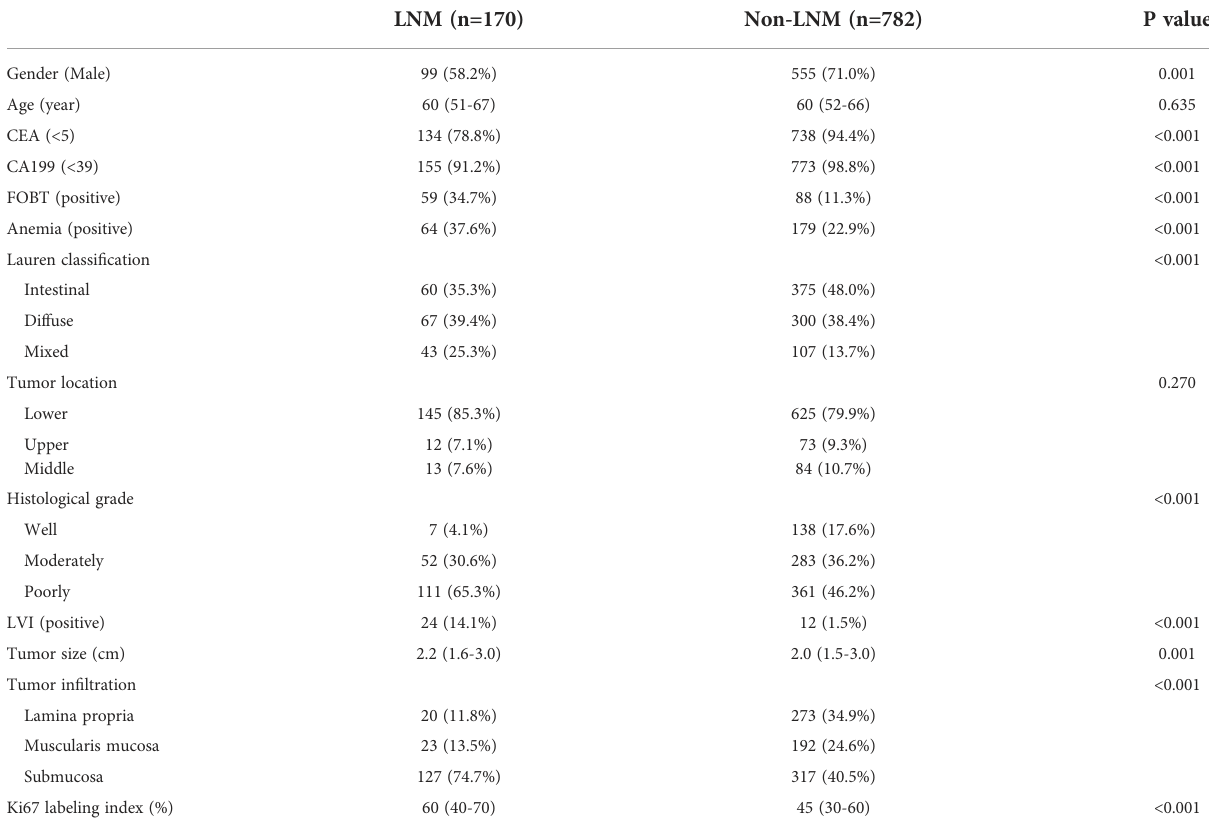
TABLE 1 Characteristics of early gastric cancer patients in LNM Set and Non-LNM